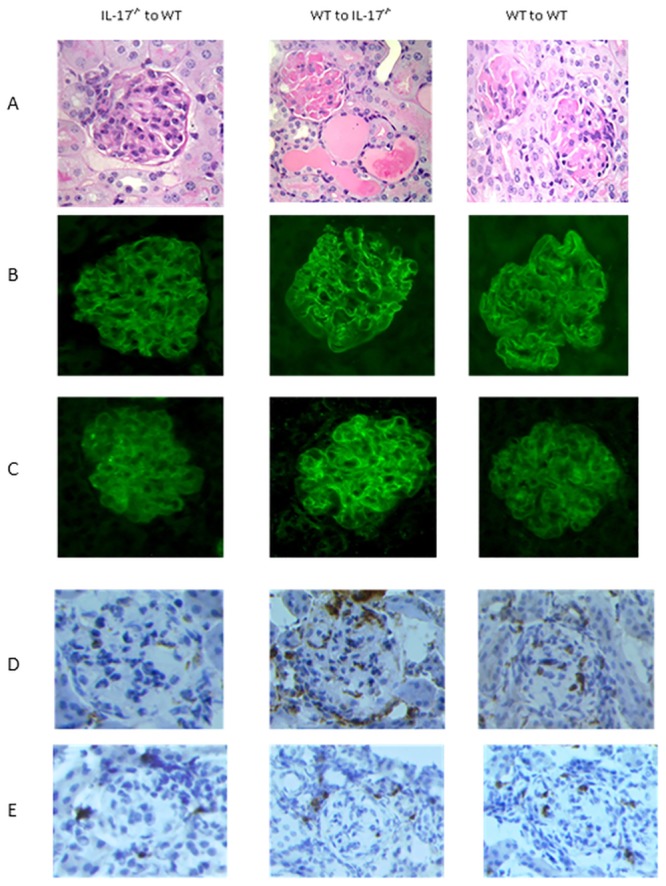
Representative histological sections from the 3 bone marrow transplant groups with NTN.(A) PAS-stained sections of renal histology. The WT to IL-17-/- group have severe glomerular thrombosis with profound tubular dilatation and casts, significantly more than the other groups. (B) and (C) Immunofluorescence for glomerular deposition of sheep and mouse IgG respectively. There was no difference between the groups. (D) and (E) Representative glomerular staining for CD68 and CD4 respectively. Magnification x400.